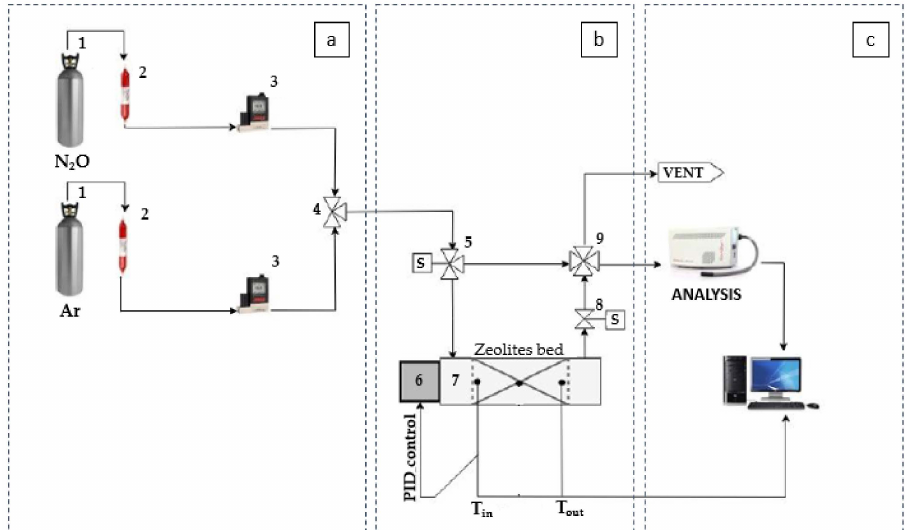
Figure 1. Sketch of the experimental plant. ( a )—feeding section: (1) gas feeding zone; (2) moisture traps; (3) mass flow controllers; ( b )—adsorption section: (4) three-way connection; (5) three-way electro valve; (6) magnetron; (7) wave guide; (8) two-way electro valve; (9) four-way connection; ( c )—analysis